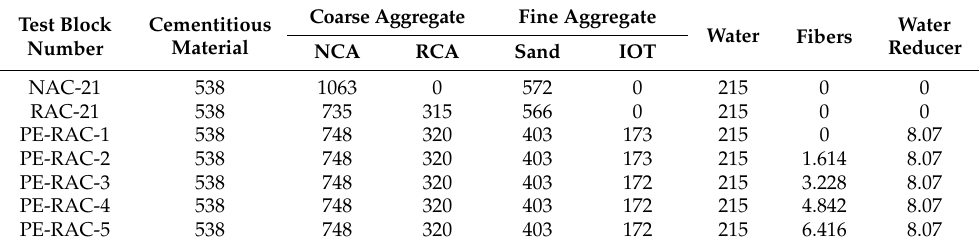
Table 1. Proportions of mixtures under different working conditions (kg/m 3 ).